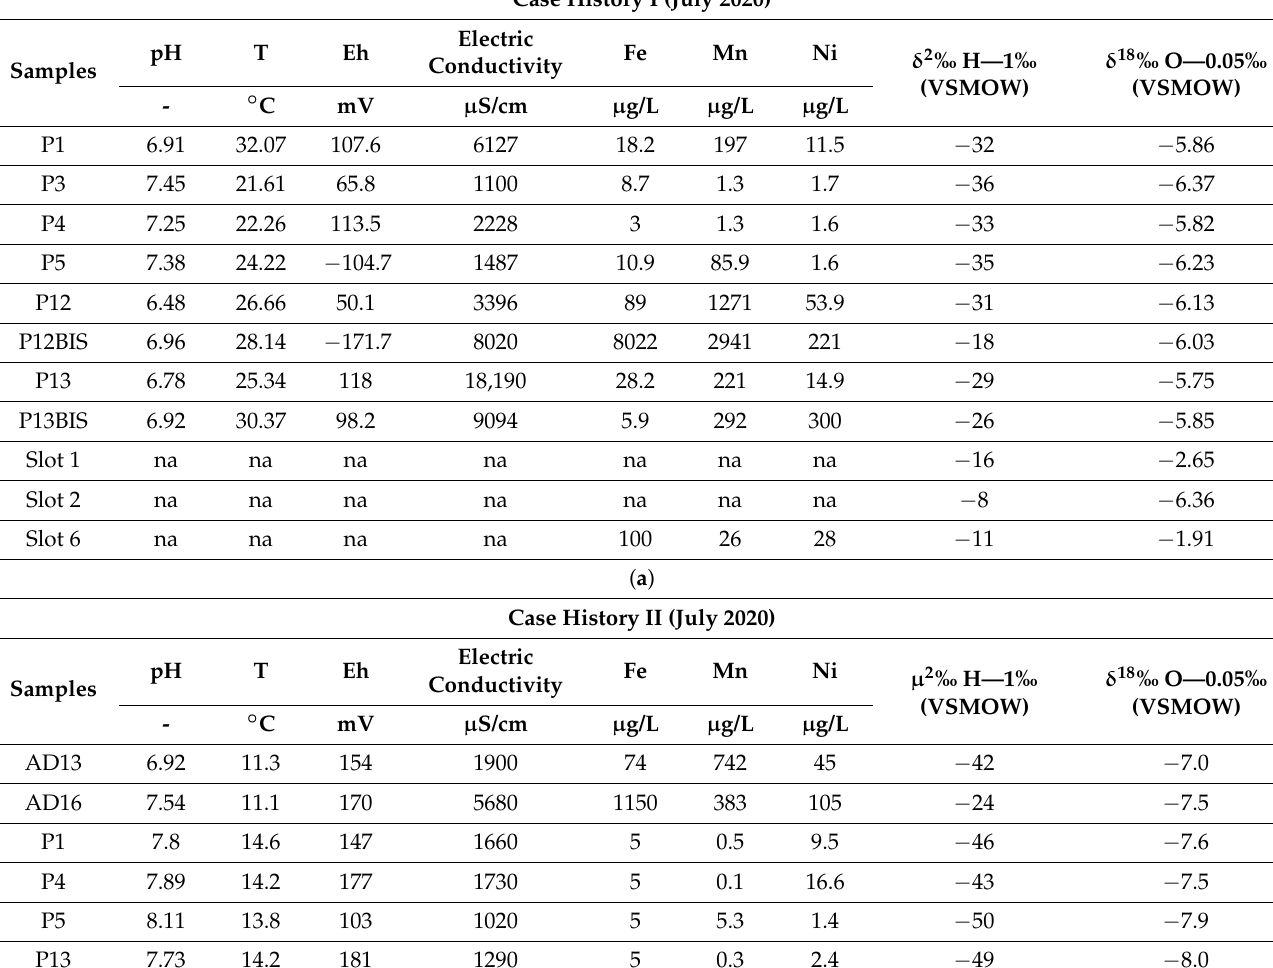
Table 2. Summary of chemical-physical parameters, Fe, Mn and Ni concentrations and isotopic data for groundwater and leachate samples: ( a ) Case History I, ( b ) Case History